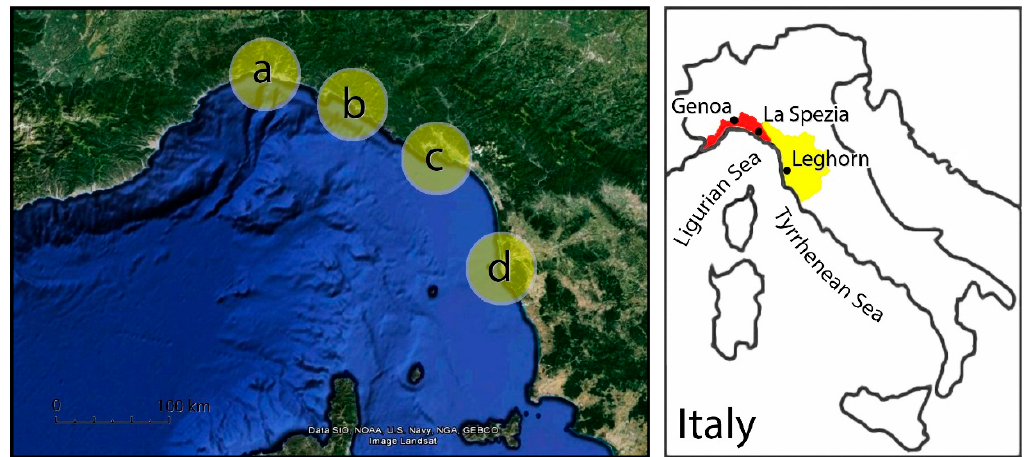
Figure 2. Location and main features of the study sites: ( a ) Pontetto (silicic flysch); ( b ) Lavagna (calcareous flysch); ( c ) Tellaro (carbonates); ( d ) Calafuria (sandstone).